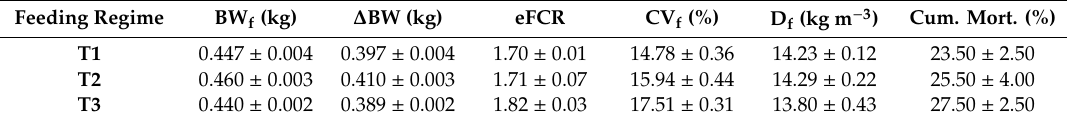
Table 5. Final harvesting results and cumulative mortality (mean ± standard error) in the experimental feeding treatments. BW f : final body weight; ∆ BW: body weight increase; eFCR: economic Feed Conversion Ratio (from stocking to harvest); CV f : final coe ffi cient of variation; D f : final fish density. Feeding Regime Feeding Regime